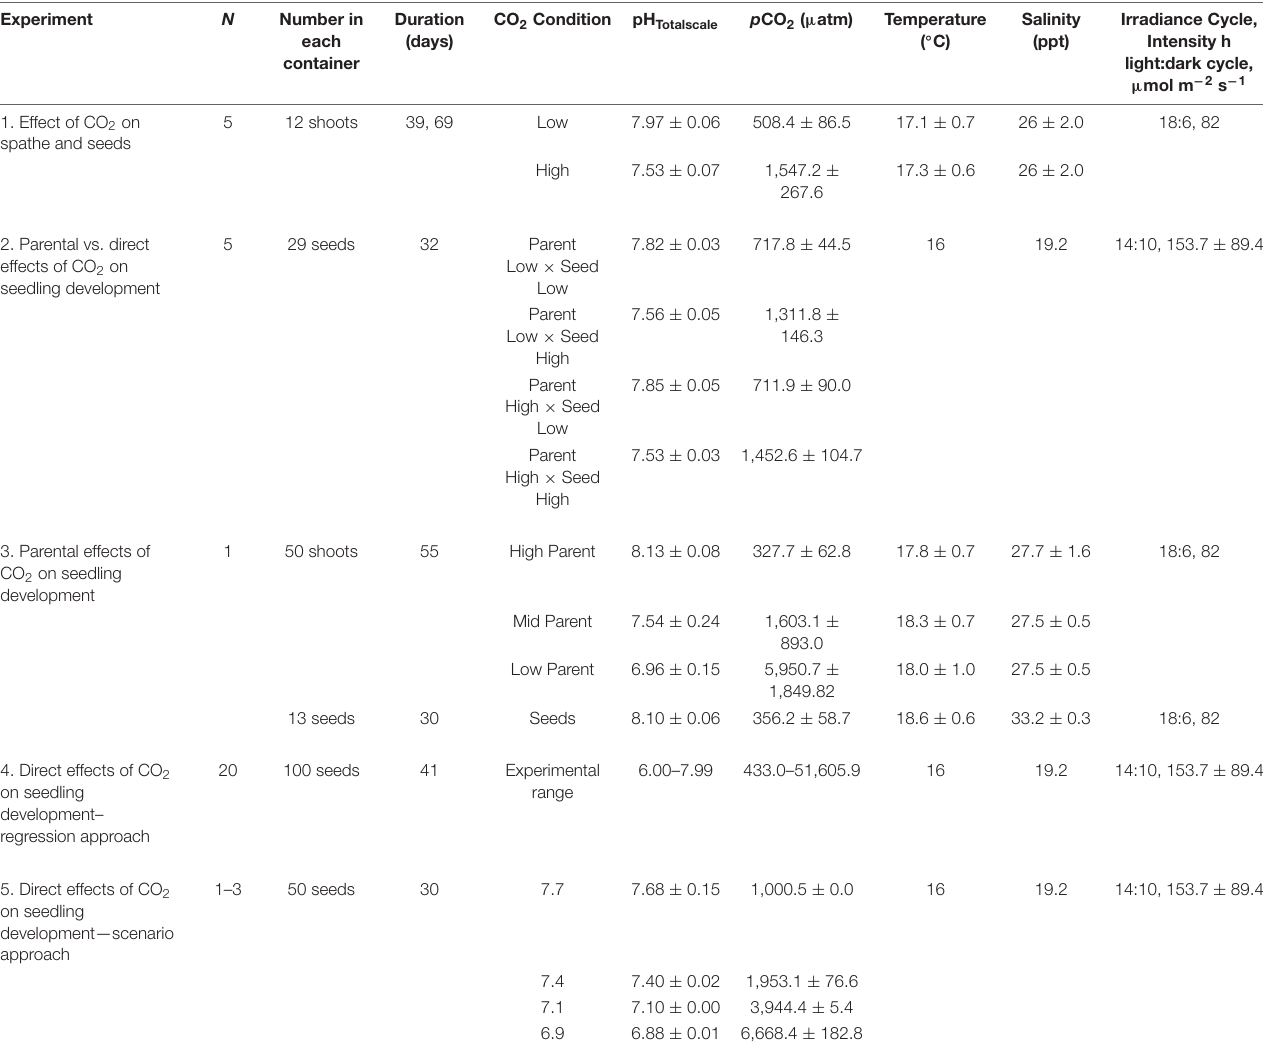
TABLE 1 | Experimental setup and conditions.